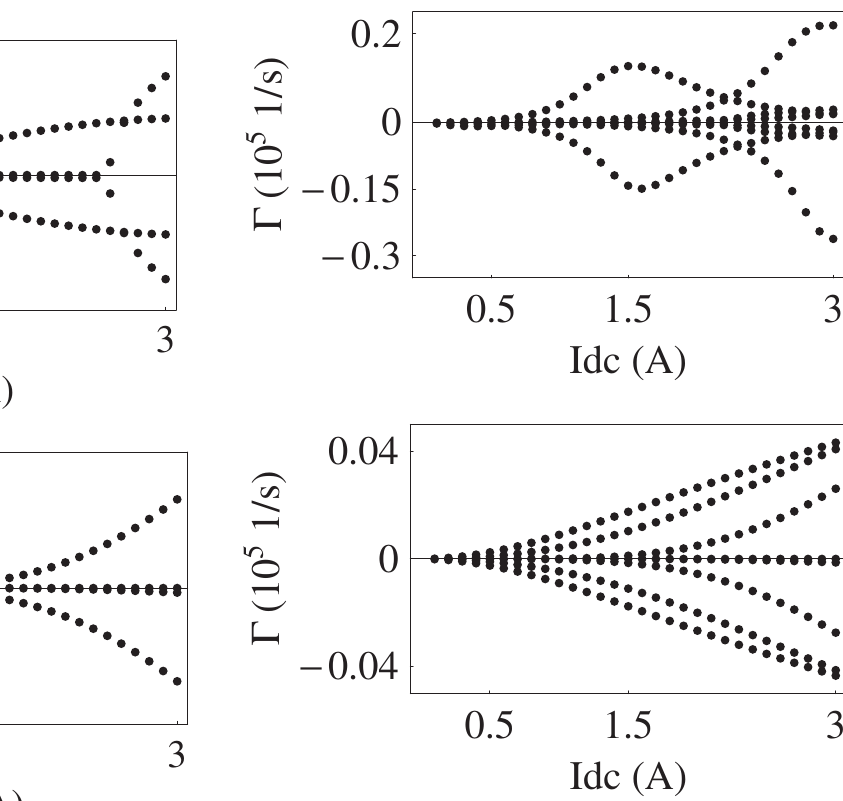
FIG. 7. Growth rate vs beam current. The FB gain (top to (cid:4) 1 . bottom) H (cid:4) f 0 : 0 ; 6 : 0 g , (cid:5) max